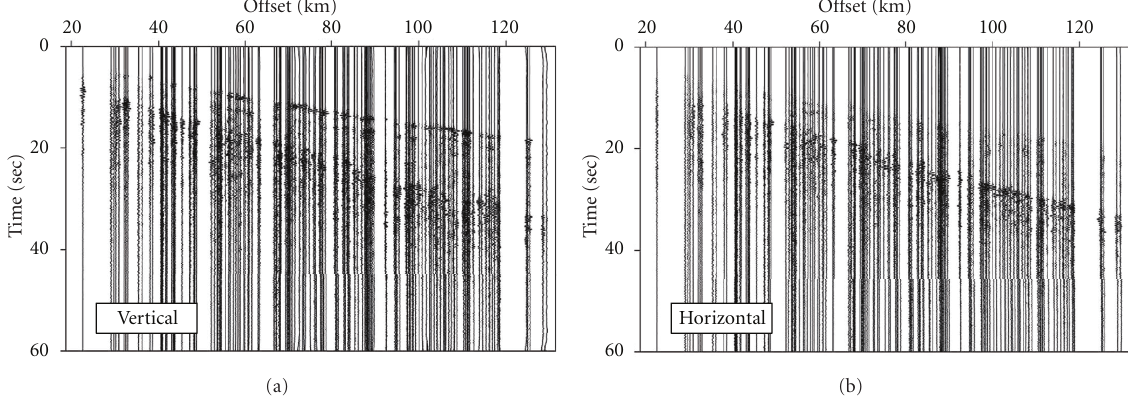
Figure 10: Recorded signal of the 168 traces from the 6 events aligned by the epicentral distance after correcting the origin time as the time of the earthquakes.